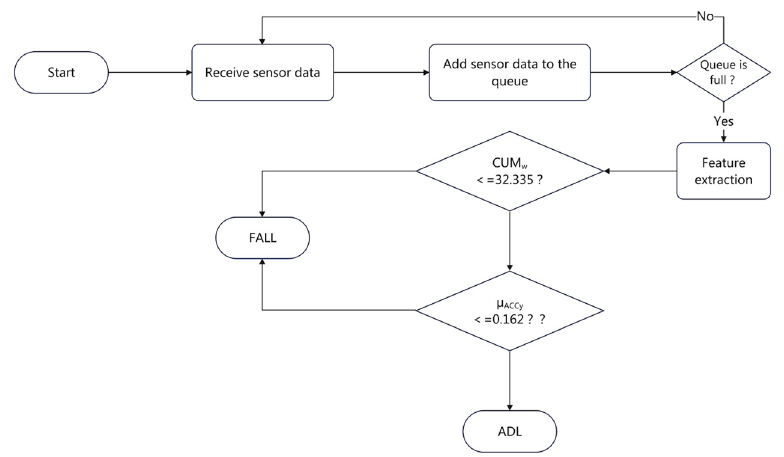
Figure 7. Frame diagram of threshold